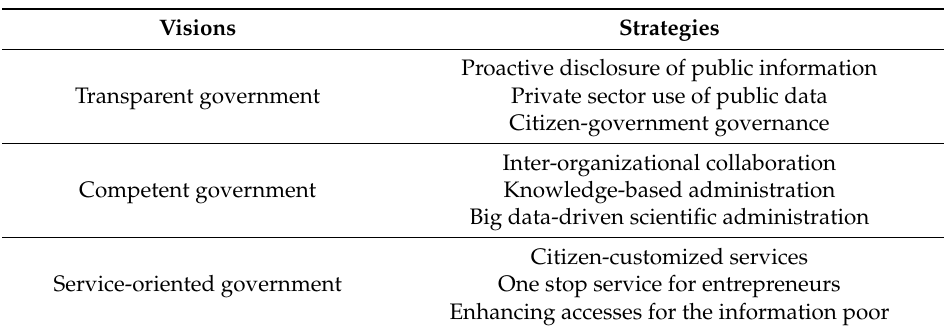
Table 1. Government 3.0